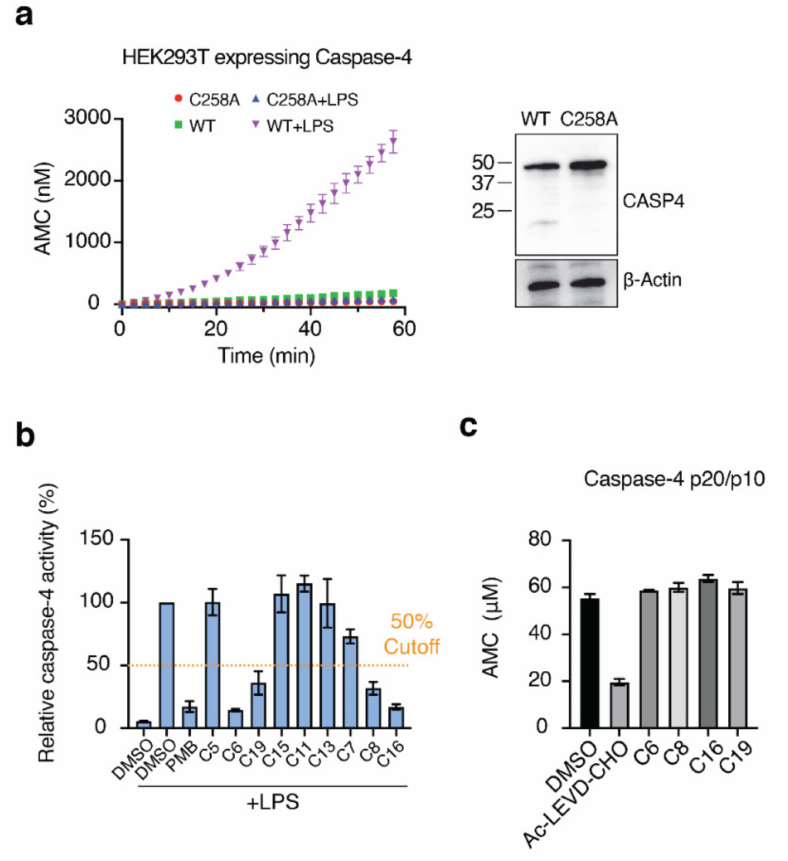
Figure 4. Four of the nine compounds inhibit the catalytic activity of Casp-4 by interrupting LPS– Casp-4 binding. ( a ) HEK293T cells were transiently transfected with p3xFLAG-CMV-10 Casp-4 or C258A-Casp-4. Cell lysates were assayed for Casp-4 activity using the substrate Ac-WEHD-AMC in the presence or absence of the activator LPS (left). Expression of recombinant proteins was analyzed by immunoblot (right). ( b ) Inhibition of Casp-4 activation by hit compounds was measured at 1 h. The dashed line indicates 50% inhibition. ( c ) Activity assay of activated Casp-4 (p20/p10) in the presence of the four compounds. Ac-LEVD-CHO was used as a competitive inhibitor of